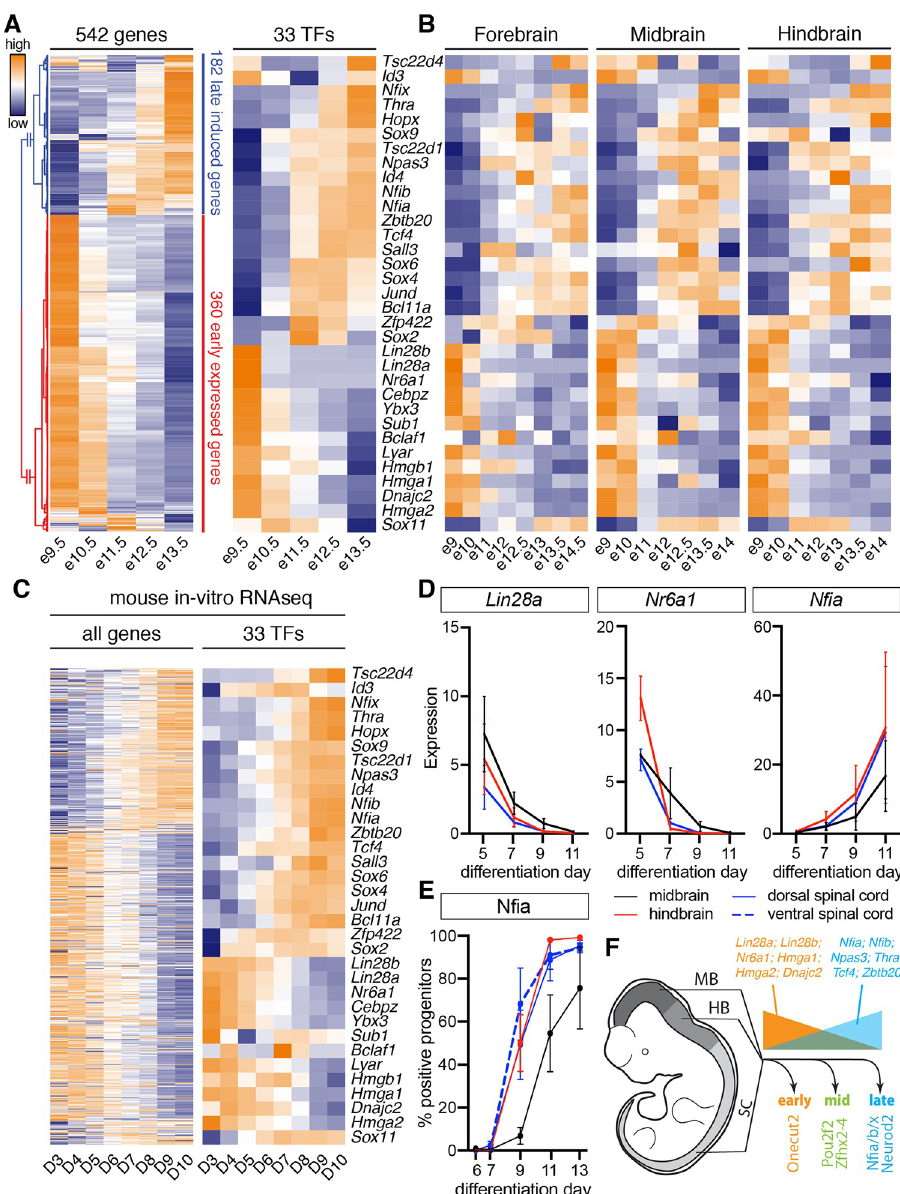
Fig 5. Conserved temporal patterning of neural progenitors throughout the developing central nervous system (see also S12 and S13 Figs). (A) Differential gene expression analysis using scRNAseq from spinal cord neural progenitors [33] identifies 542 genes (left) including 33 TFs (right) that are differentially expressed during the neurogenic period. Heatmap shows log-scaled and z-scored gene expression values for each gene. (B) Characterization of the expression dynamics of the same 33 TFs in scRNAseq from the developing forebrain, midbrain, and hindbrain [9]. (C) Expression dynamics of the 542 genes (left) and 33 TFs (right) in RNAseq data from ventral spinal cord differentiations [69]. Heatmap shows log-scaled and z-scored gene expression values for each gene. Order of the genes in both heatmaps is the same as in (A). (D) RT-qPCR analysis of Lin28a , Nr6a1 , and Nfia from days 5–11 in in vitro differentiations with different axial identities reveals conserved expression dynamics of these markers in the in vitro differentiations. See S13D Fig for quantification of further markers. Underlying data are included in S4 Data. (E) Quantification of Nfia induction in in vitro generated neural progenitors with different axial identities by flow cytometry. For underlying data, see S3 Data. (F) Conserved temporal patterning of neural progenitors throughout the developing nervous system. Early neural progenitors express markers such as Lin28a , Lin28b , Nr6a1 , Hmga1 , Hmga2 , and Dnajc2 (orange), while late progenitors are characterized by the expression of Nfia , Nfib , Npas3 , Thra , Tcf4 , and Zbtb20 (light blue). HB, hindbrain; MB, midbrain; RT-qPCR, real-time quantitative polymerase chain reaction; SC, spinal cord; scRNAseq, single-cell RNA sequencing; TF, transcription factor.